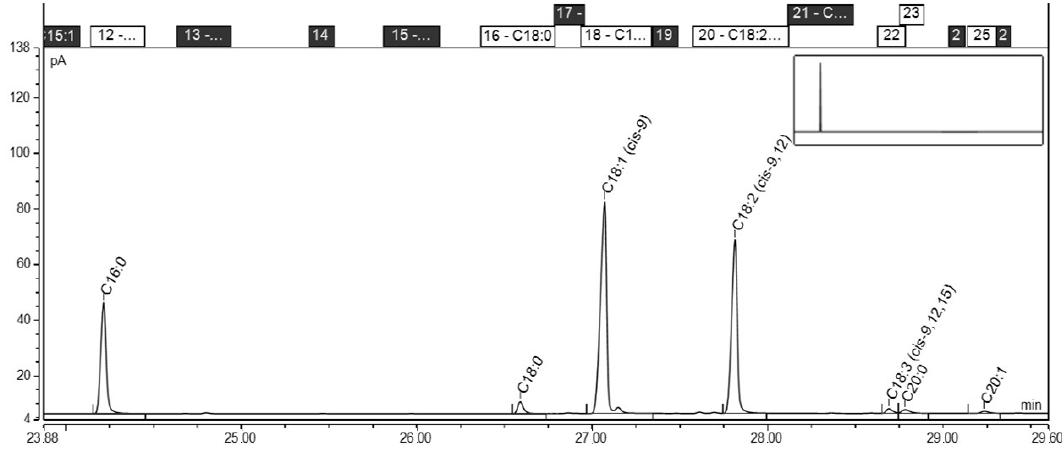
Figure 2. Chromatogram of rice bran oil.